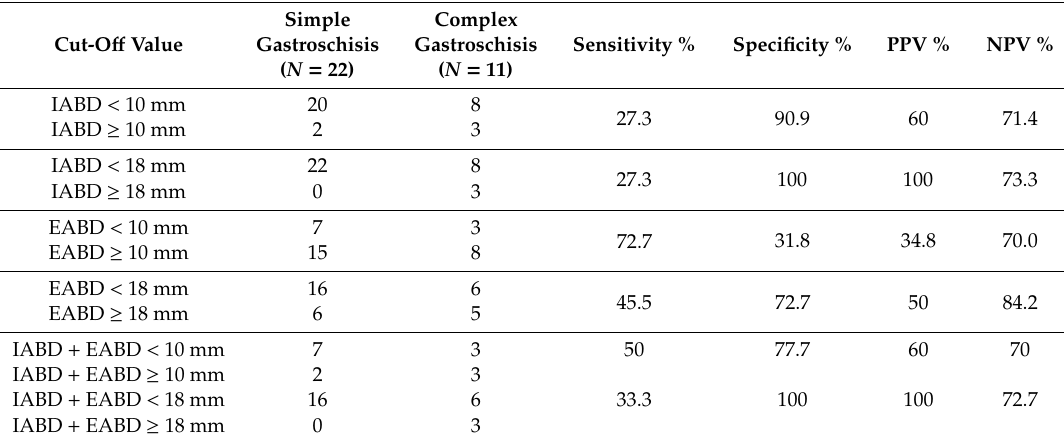
Table 2. Prediction of complex gastroschisis with intraabdominal bowel dilatation (IABD) and extra-abdominal bowel dilatation